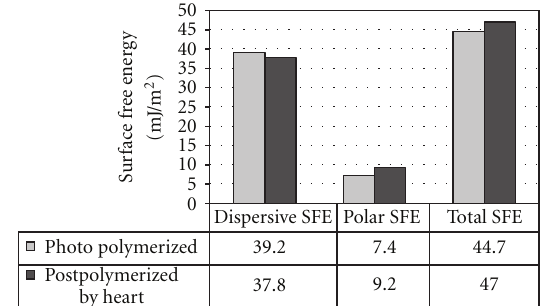
Figure 8: Dispersive ( γ D ), polar ( γ P ), and total ( γ TOT ) components of surface free energy (SFE) for the plain polymer specimens with di ff erent polymerization methods calculated using the Owens-Wen- dt